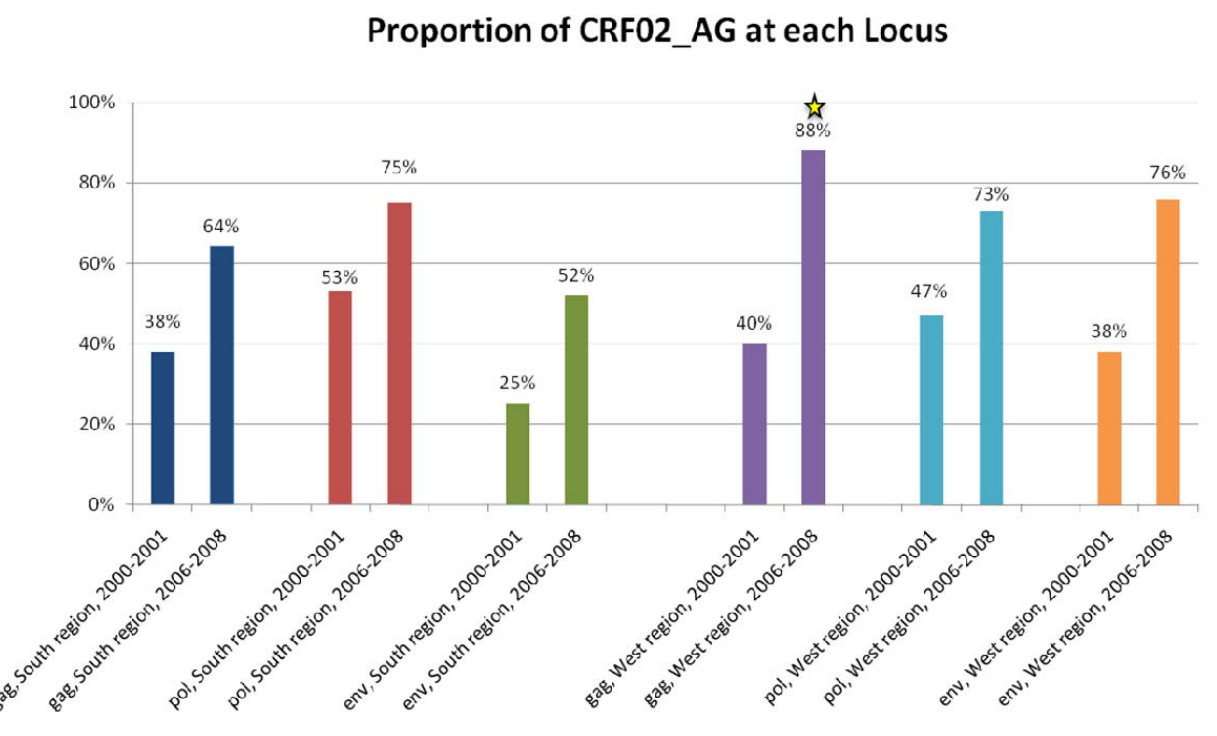
Figure 3. Proportion of CRF02_AG at each locus, South and West regions. Statistically significant increase (p < 0.05) is denoted by an